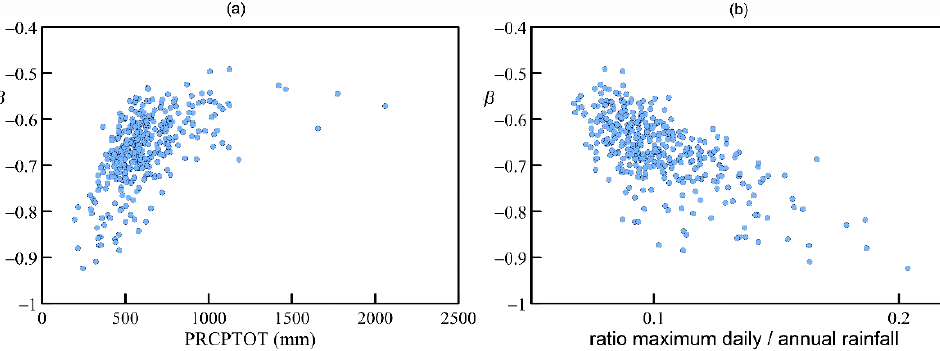
Figure 6. Dependence of the scaling parameter 𝛽 on ( a ) mean annual rainfall PRCPTOT and ( b ) the mean ratio between the maximum daily and the annual rainfall in every station.